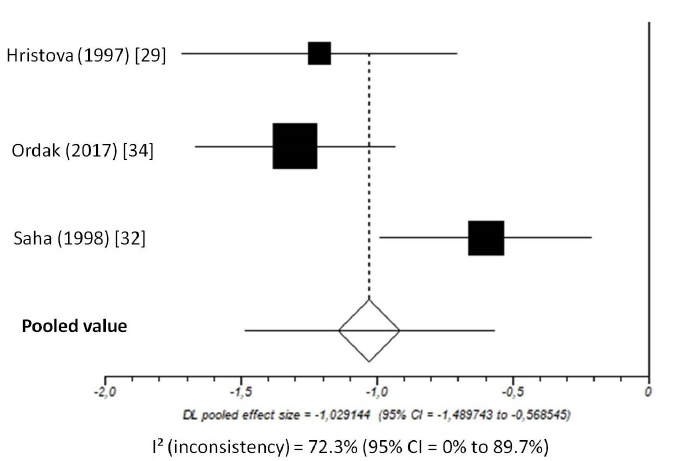
Figure 4. Forest plot of individual studies and pooled mean difference of ionized magnesium between alcohol group and controls, including 95% confidence intervals (95%-CI). The size of the squares is related to the weight of each study. Number of patients and control subjects in each study: Hristova [29]: controls n = 40, patients n = 31; Ordak [34]: controls n = 50, patients n = 100; Saha [32]: controls n = 75, patients n =